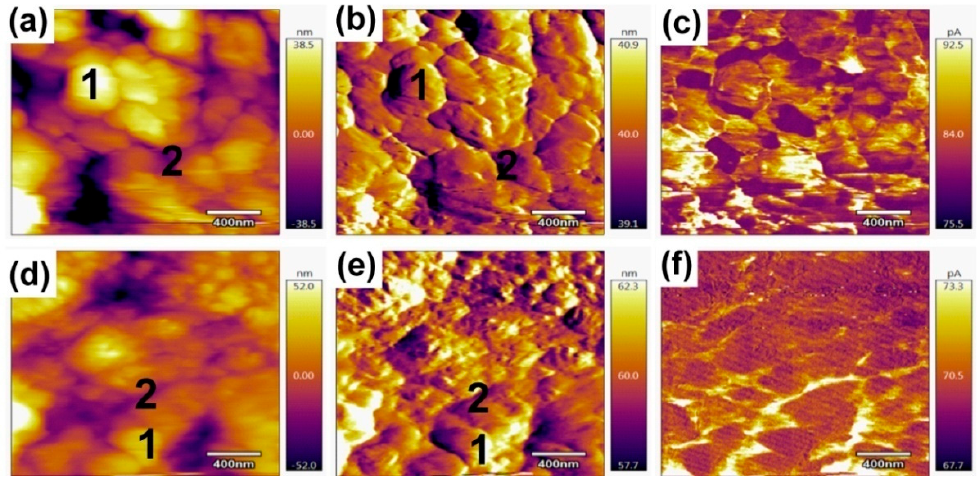
Figure 6. Grain boundary morphology dependent current measured by c-AFM for iodine-doped perovskite films ( a – c ) and pristine perovskite films ( d – f ). ( a ) Height and ( b ) deflection maps of the same area of iodine-doped perovskite; ( c ) Dark current measured with the c-AFM tip in contacting with the iodine-doped perovskite; ( d ) Height and ( e ) deflection maps of the same area of pristine perovskite; ( f ) Dark current measured with the c-AFM tip in contacting with the pristine perovskite.